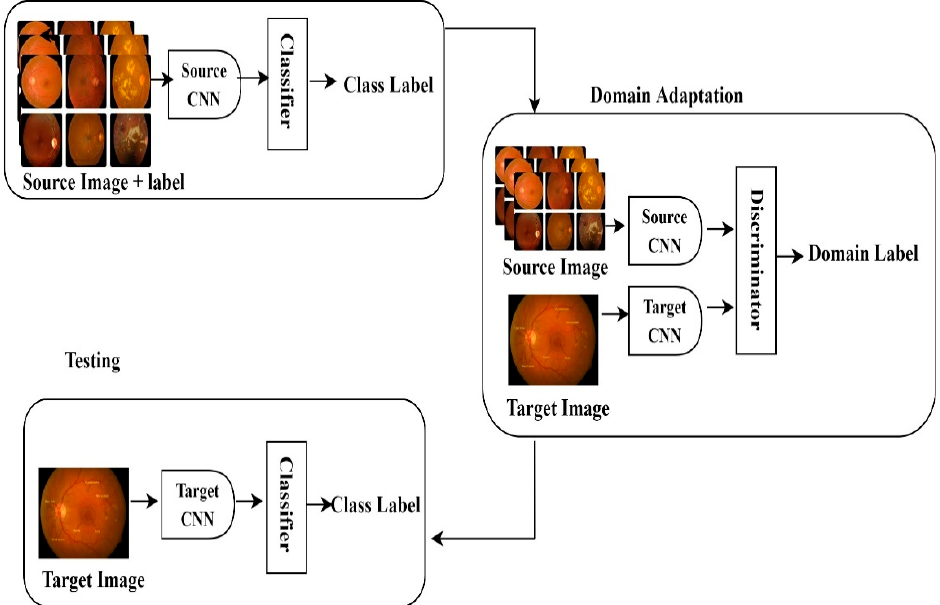
Figure 14. Diabetic retinopathy using domain adaptation.